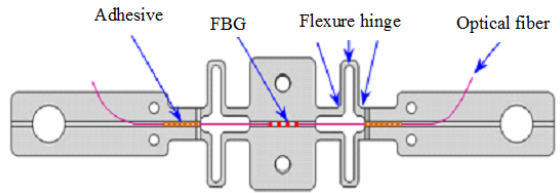
Fig. 19 Schematic of the elastic body and FBG